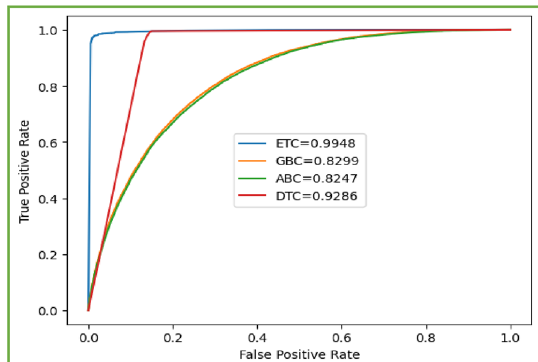
Fig. 3 The ROC plot of all classifiers for the BRFSS